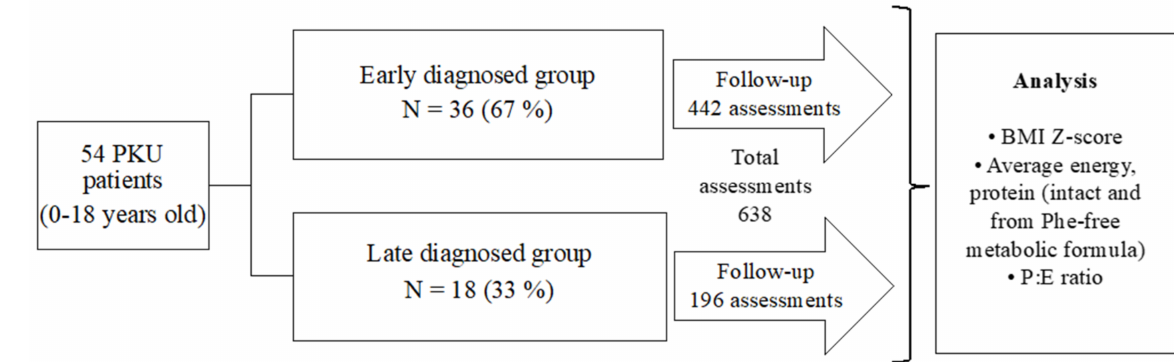
Figure 1. Design of the